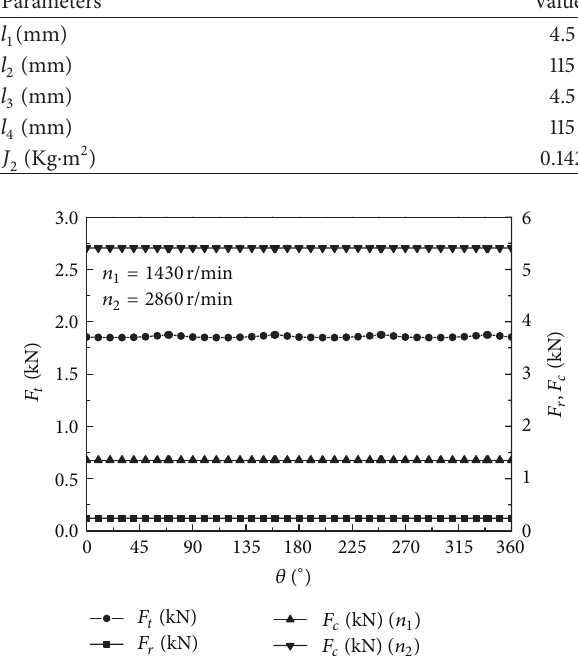
Figure 4: The diagram of external force.